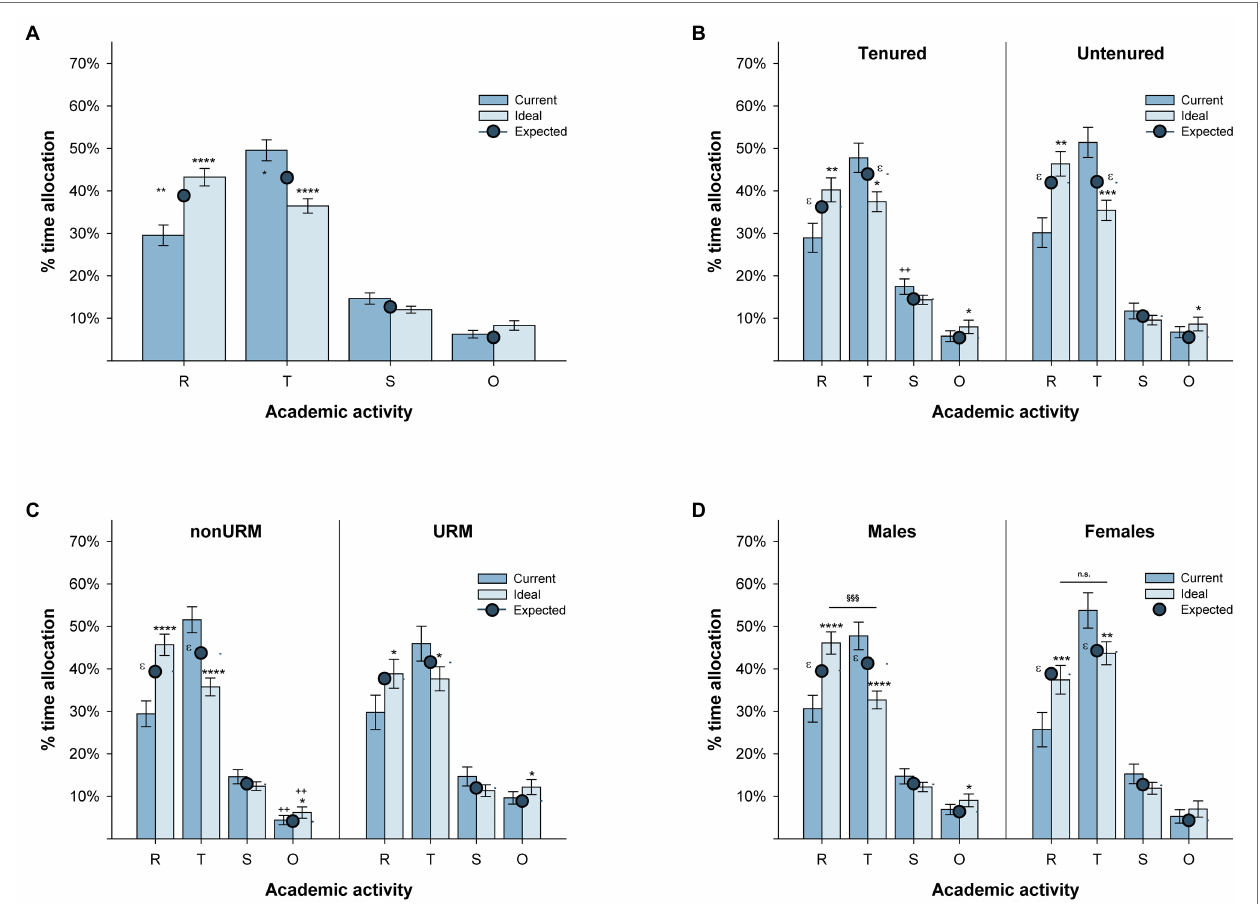
FIGURE 1 | Percent time allocation. Time allocation for all faculty (A) , faculty’s tenure status (B) , representation (C) , and gender (D) . In the horizontal axis, R, research; T, teaching; S, service; and O, outreach. For comparisons between current and ideal time allocation, * p adj < 0.05, ** p adj < 0.01, *** p adj < 0.005, and **** p adj < 0.001. For comparison between ideal time allocation to research and teaching, §§§ p adj < 0.001 and n.s, not significant. For comparisons between current and expected time allocation, ɛ p < 0.05. Brackets represent standard error of the mean. See text for further